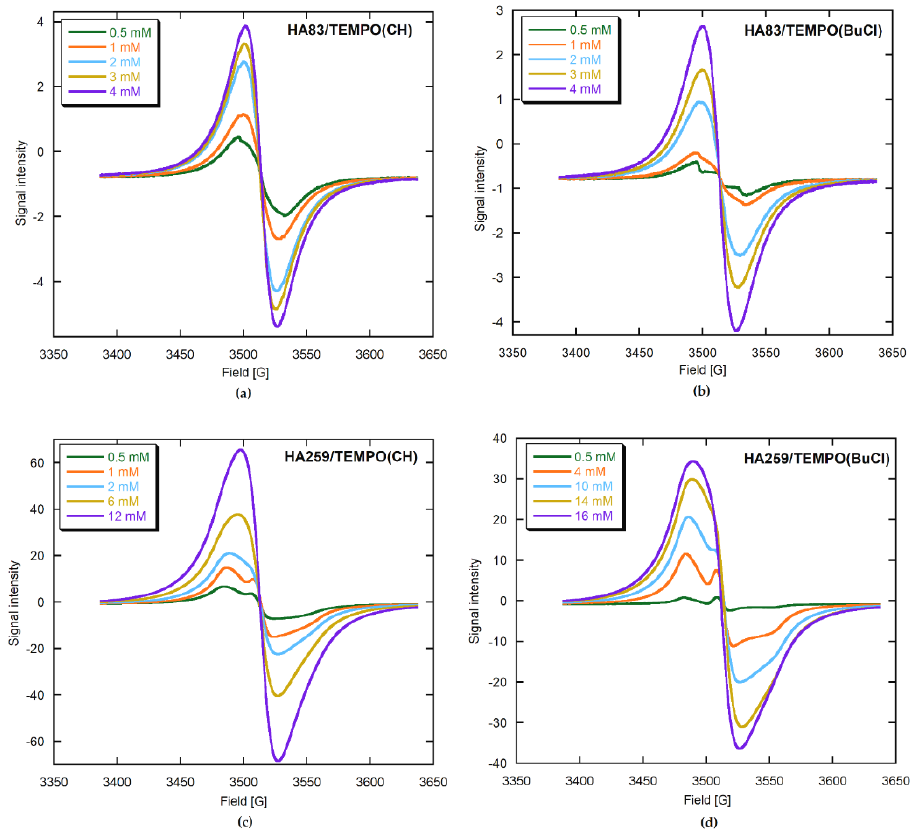
Figure 3. The EPR spectra of TEMPO from the obtained composites showing signal dependence on the initial radical concentration in the organic solvent: ( a ) after adsorption on HA83 from CH; ( b ) after adsorption on HA83 from 1-chlorobutane (BuCl); ( c ) after adsorption on HA259 from CH; ( d ) after adsorption on HA259 from